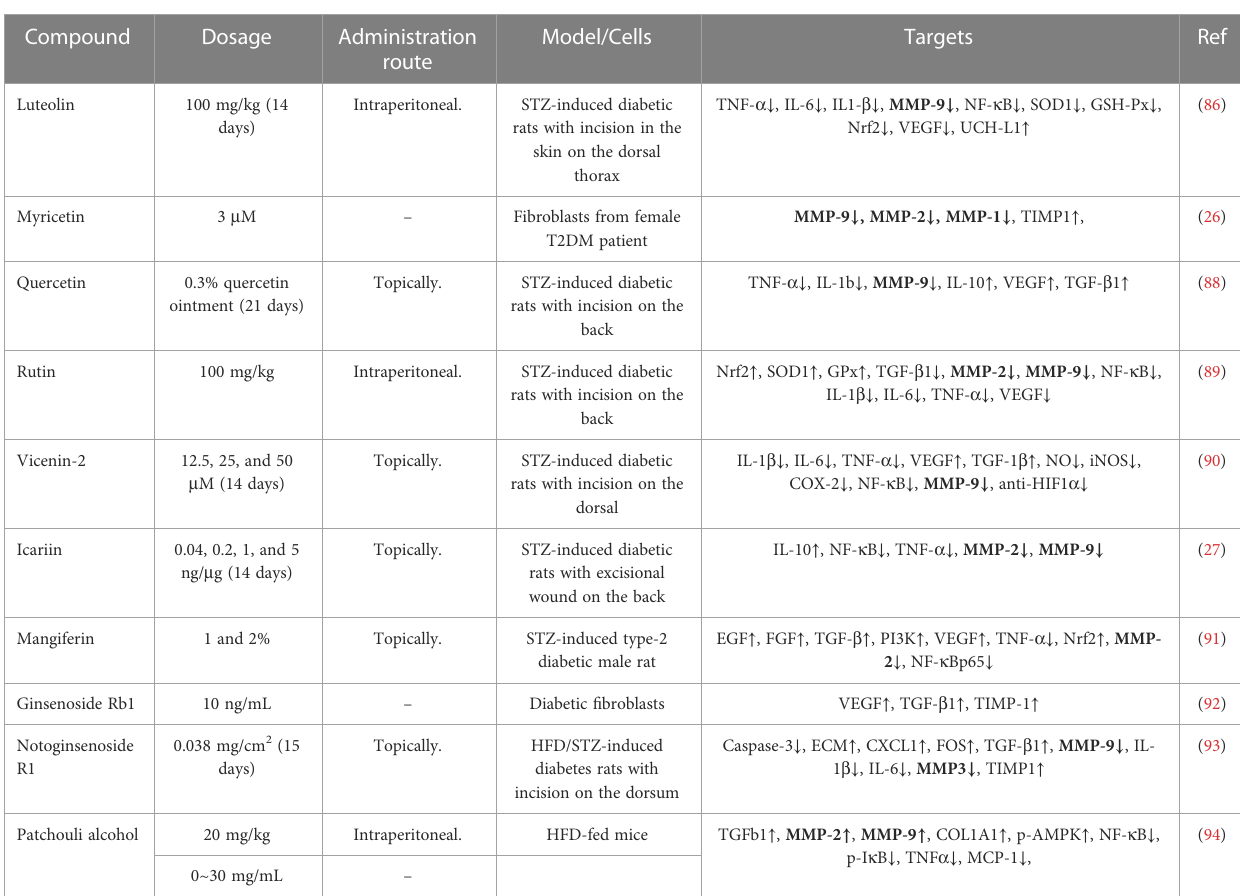
TABLE 1 Natural products in diabetic wound healing targeting MMPs. Compound